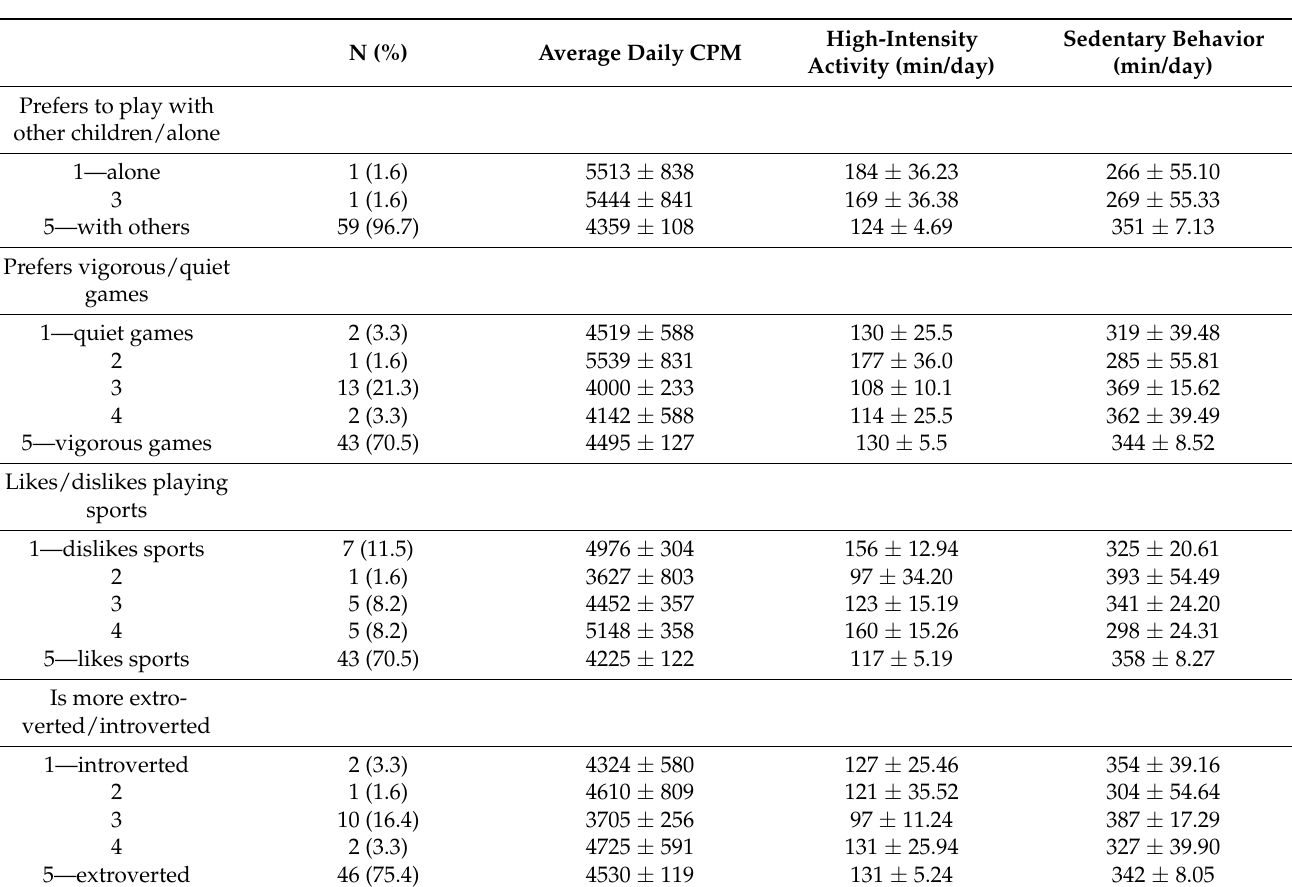
Table 4. Accelerometer-measured physical activity (EMM ± SE) according to individual NPAQ